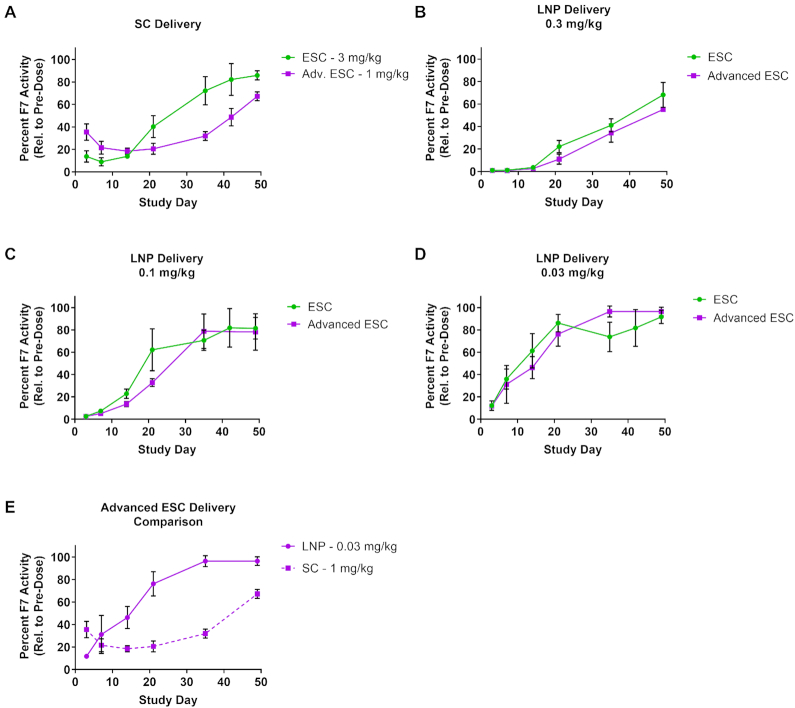
siRNA route of delivery affects target knockdown profile and duration of effect. (A) GalNAc–siRNAs were dosed SC at 3 mg/kg (ESC, siF7-1) or 1 mg/kg (Advanced ESC, siF7-3) and plasma F7 protein activity relative to pre-dose was measured. (B–D) ESC and Advanced ESC GalNAc–siRNAs were formulated into LNPs and delivered by IV at 0.3, 0.1 and 0.03 mg/kg. Both conjugate (SC) and LNP (IV) arms of the experiment were monitored for 49 days by measuring F7 protein activity in the blood. (E) A comparison between the Advanced ESC siRNA delivered as an LNP (0.03 mg/kg, siF7-3) or conjugate (1 mg/kg, siF7-3) is shown. Data is represented as mean ± SD, for N = 3.